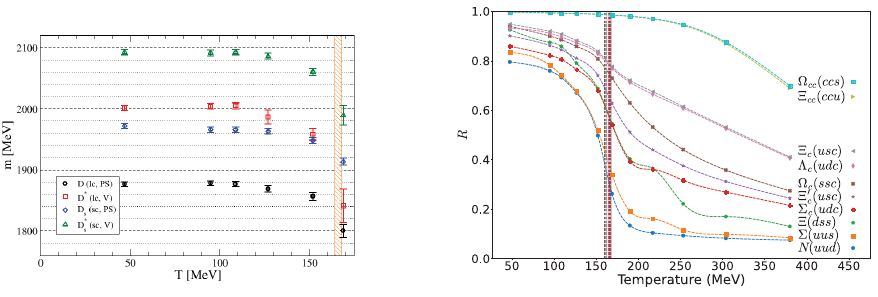
Figure 2. Left: open charm masses from analysis of smeared correlators [18]. Right: the parity charmed baryons [19]. The vertical band indicates the chiral doubling parameter R for spin- 1 2